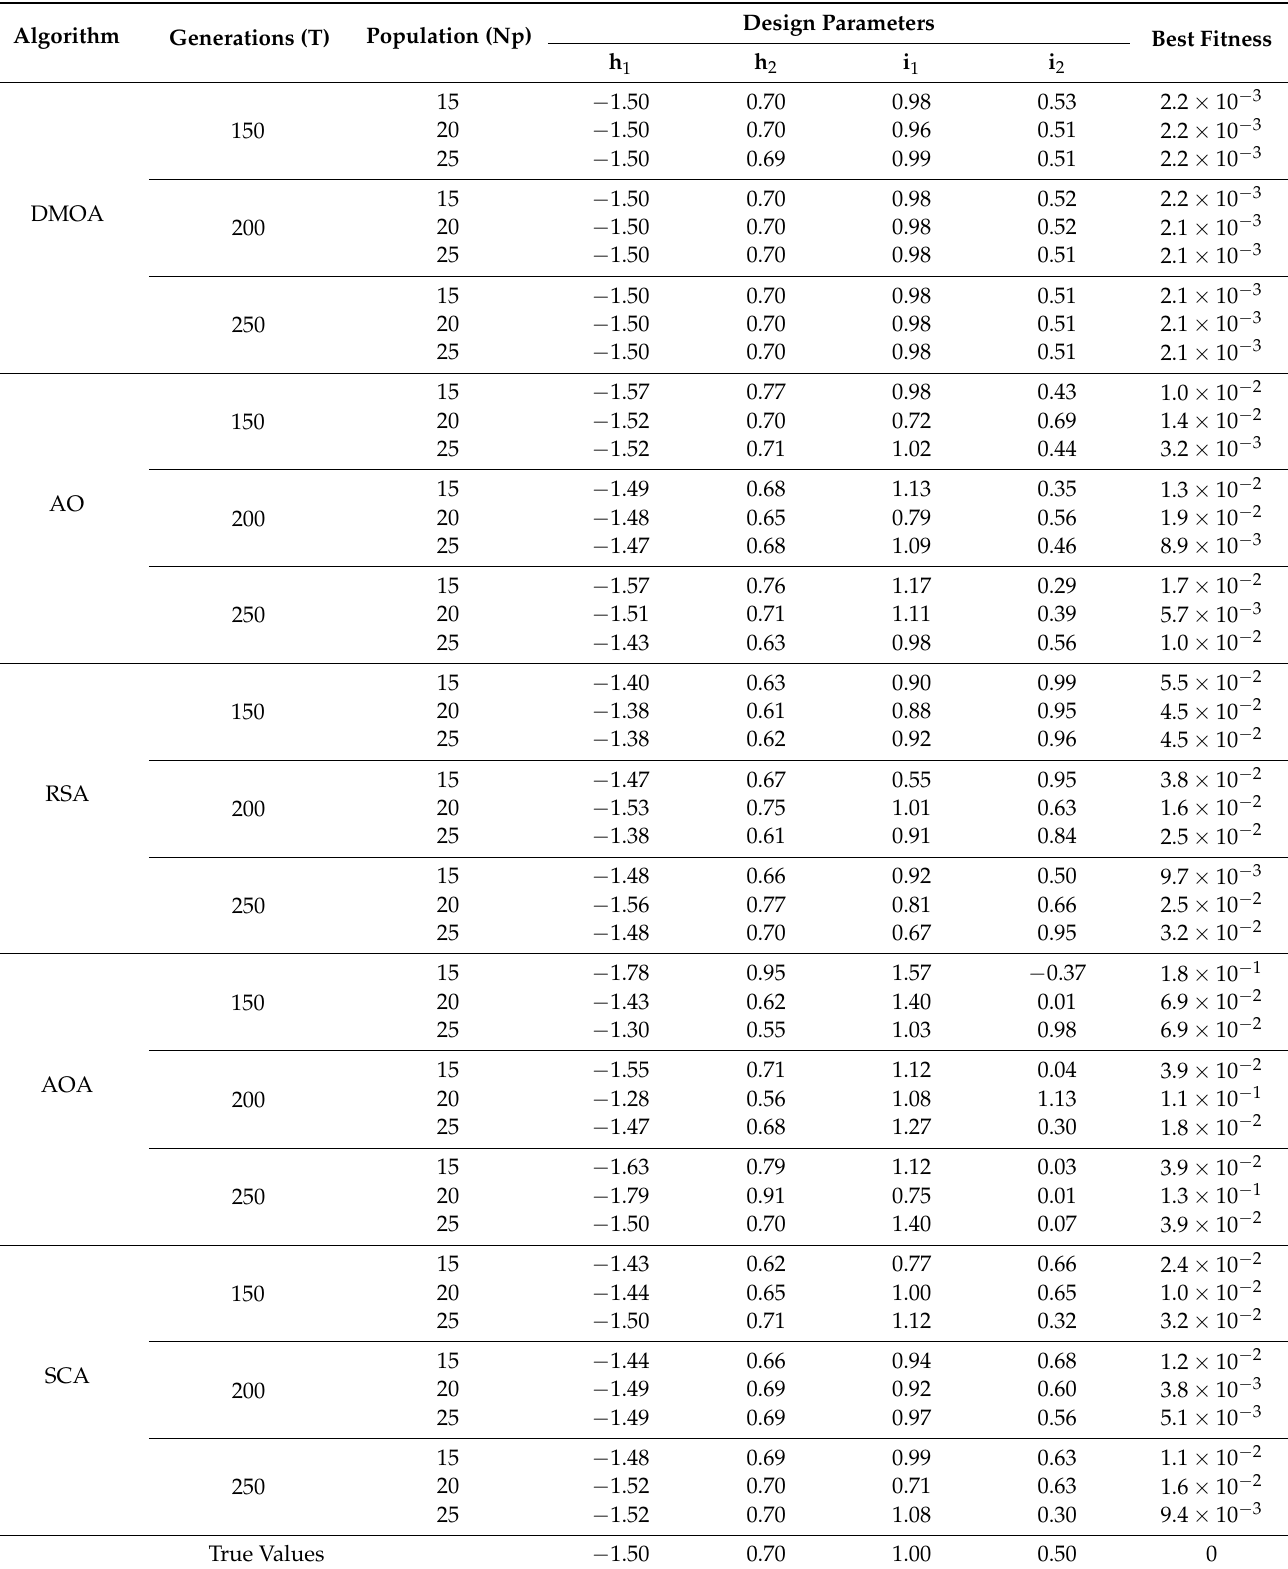
Table 8. Comparison of the DMOA with the AO, RSA, AOA and SCA against true values for the ARX model at 0.05 noise